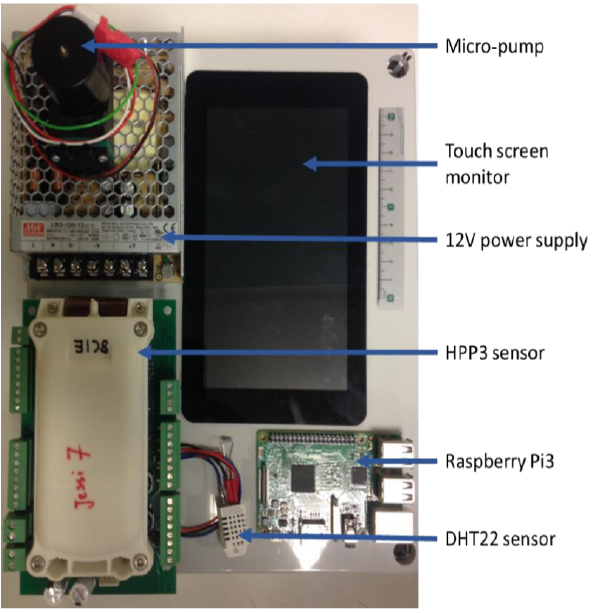
Figure 1. Components of the portable instrument on the top of its